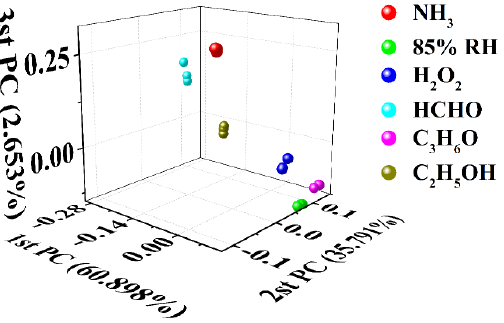
Figure 6. Principal component analysis diagram derived from the responses of 5 − 3H, 6 − 3H, and 7 − 3H to 1000 ppm of NH 3 , H 2 O 2 , C 3 H 6 O, CH 2 O, C 2 H 5 OH vapors and 85% RH at room